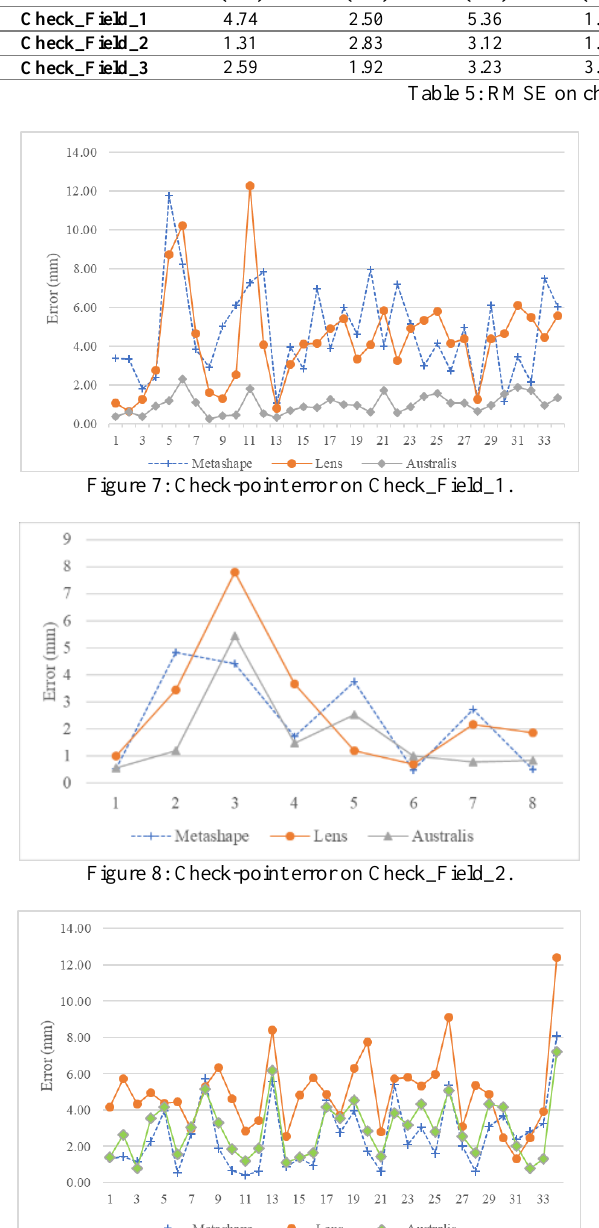
Figure 9: Check-point error on Check_Field_3.